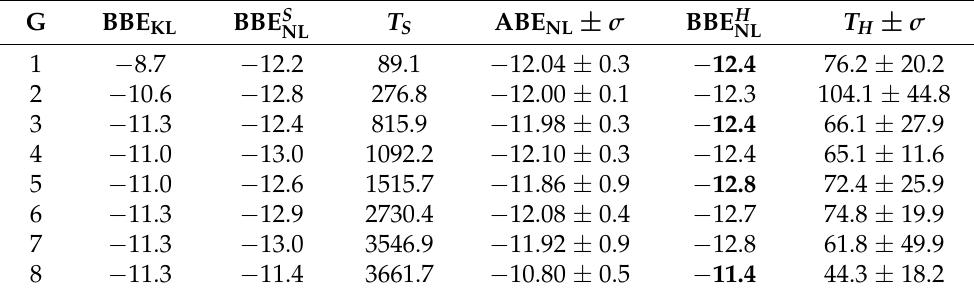
Table 7. The best binding energy (BBE KL ) of known ligands, the best binding energy (BBE S ) and the NL computational time ( T S ) in minutes with the semi-exhaustive approach, the average binding energy (ABE NL ), the best binding energy (BBE H ) and the average computational time ( T H ) in minutes for NL each group with the heuristic search approach. The binding energy equal or lower than the obtained by the semi-exhaustive approach is shown in bold .